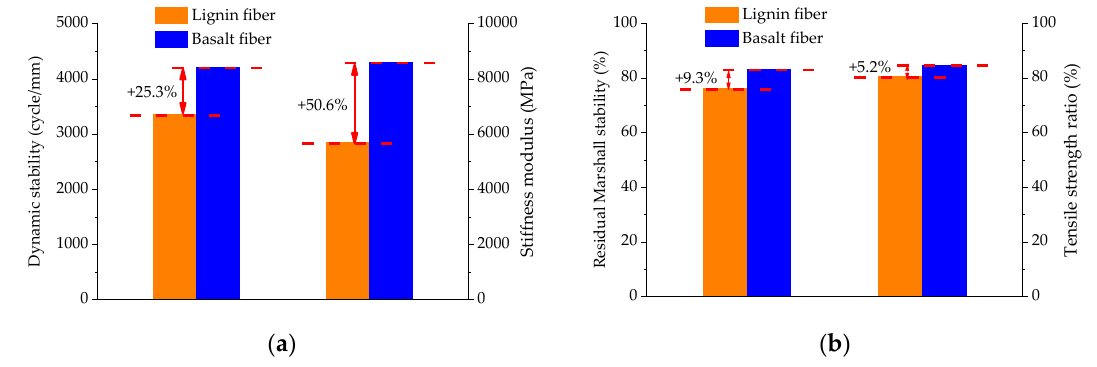
Figure 16. Pavement performance test results: ( a ) High-temperature dynamic stability and low-temperature cracking resistance; ( b ) Moisture stability.